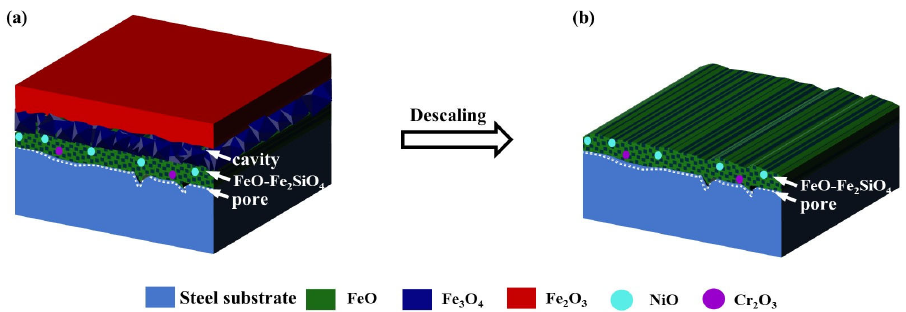
Figure 13. Schematic diagram of the high-pressure water descaling mechanism in 300 M steel at elevated temperature: ( a ) Before descaling; ( b ) After descaling.